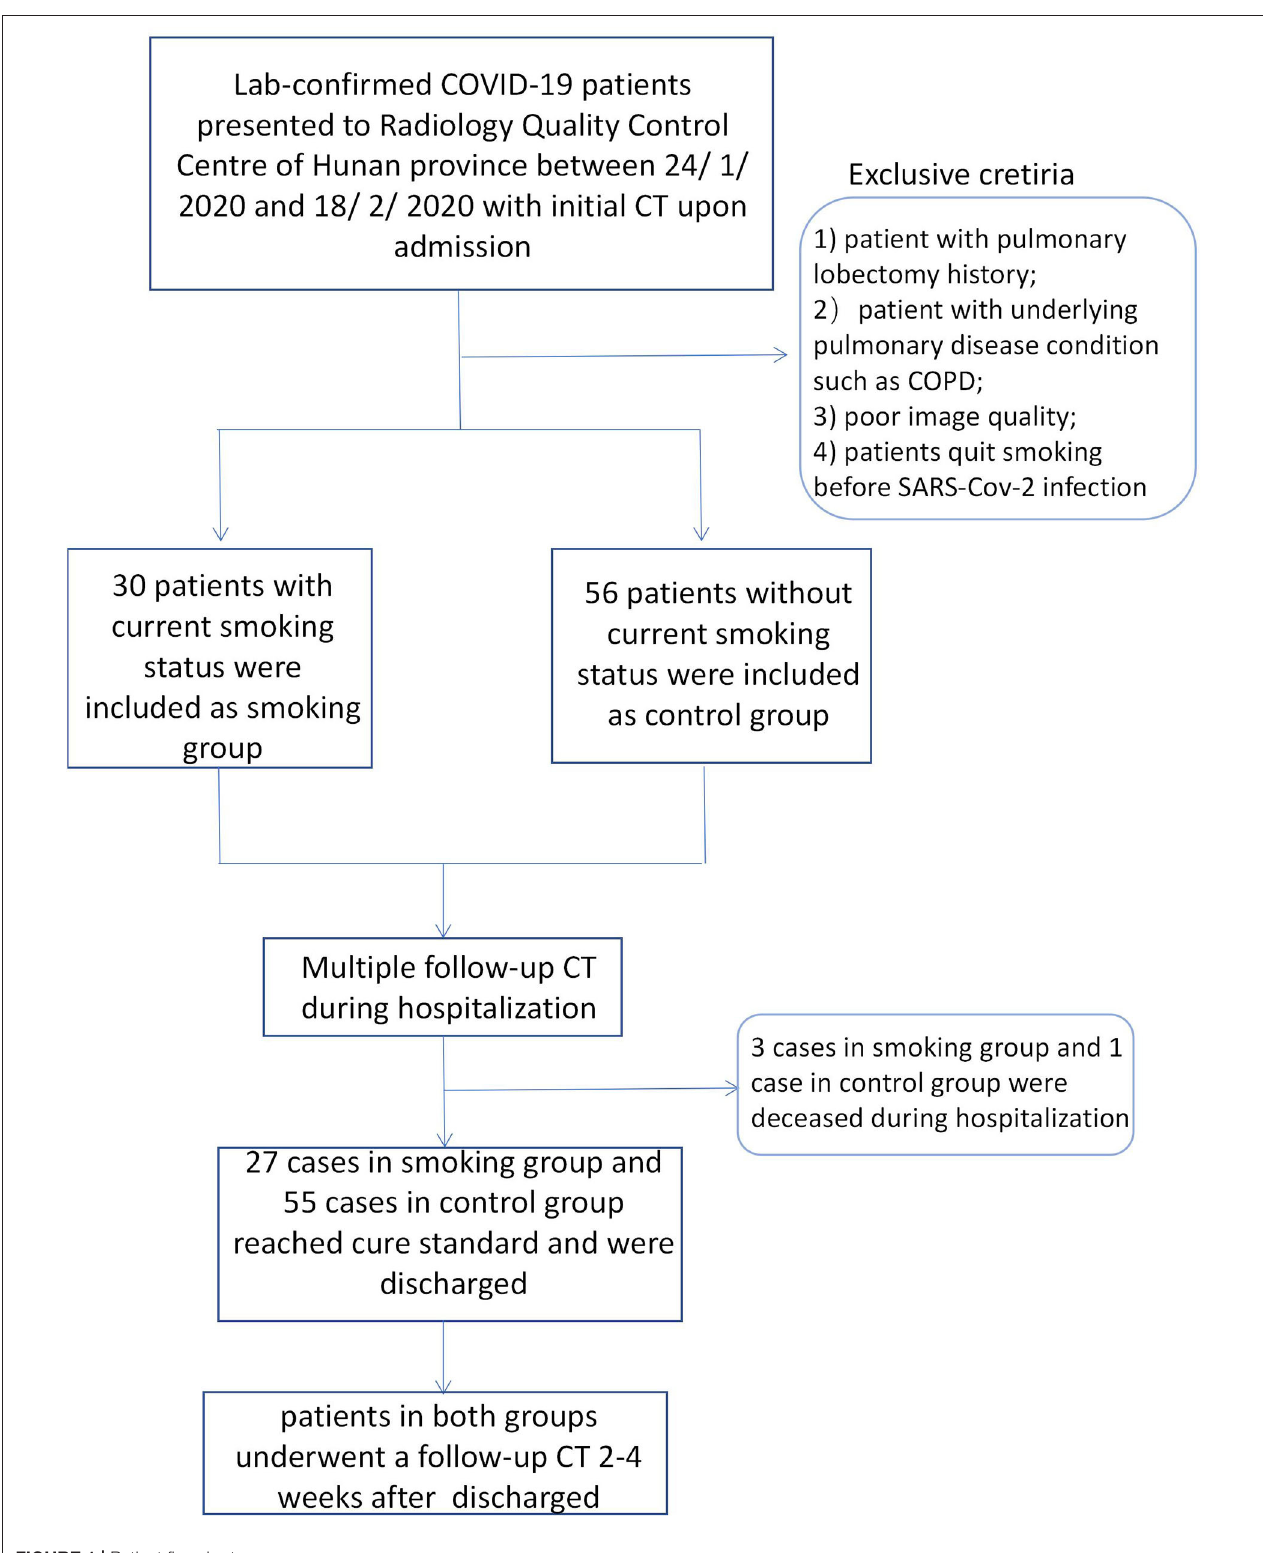
FIGURE 1 | Patient